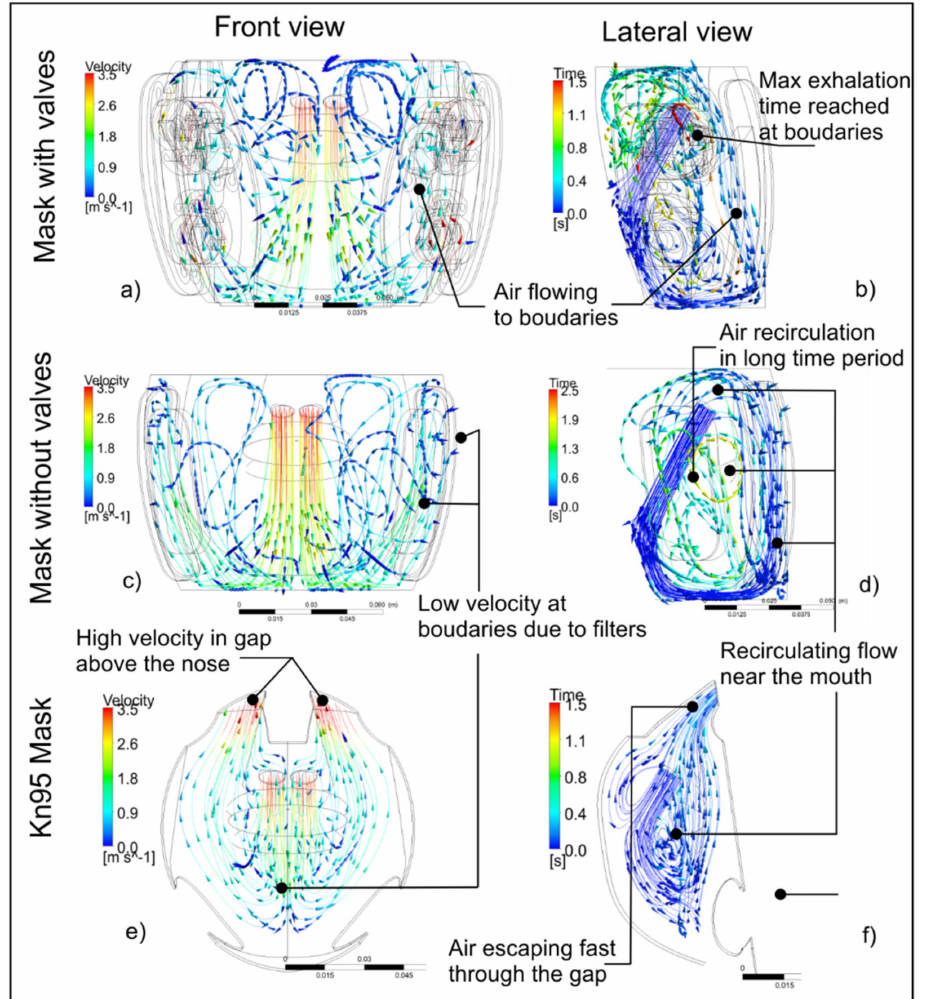
Figure 11. Streamlines of velocity and time for each mask and exhalation event at 3.5 m/s through the nose. ( a , b ) Case with static valves; ( c , d ) case without static valves; ( e , f ) KN95 mask